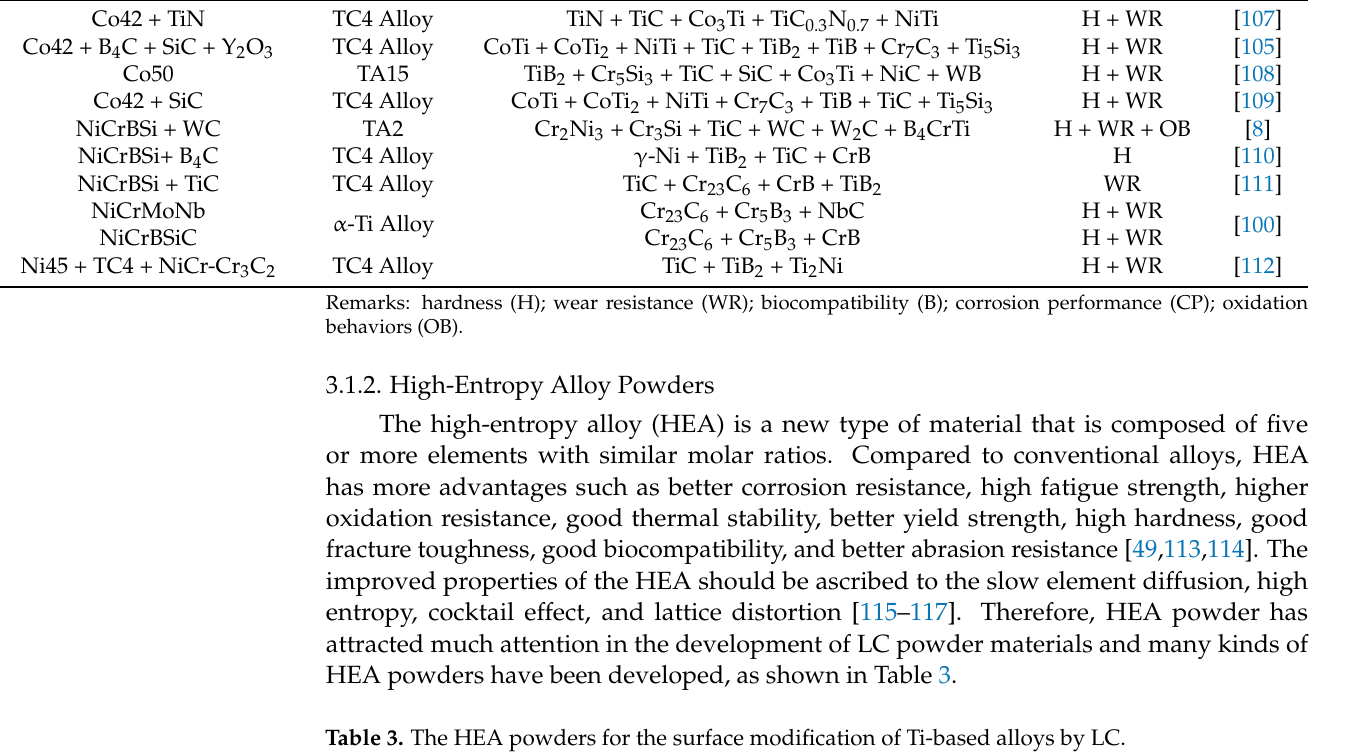
Table 2. The self-fluxing alloy powders for the surface modification of Ti-based alloys by LC. Cladding Materials